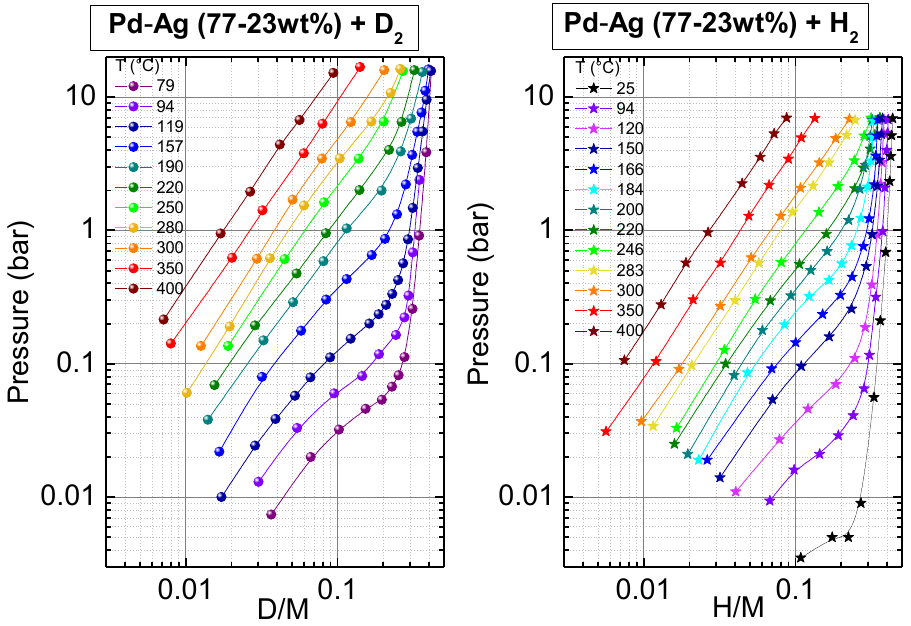
Figure 1. Absorption pressure–composition isotherms measured at selected temperatures for Pd 77 Ag 23 with D 2 ( left ) and H 2 ( right ) gas.